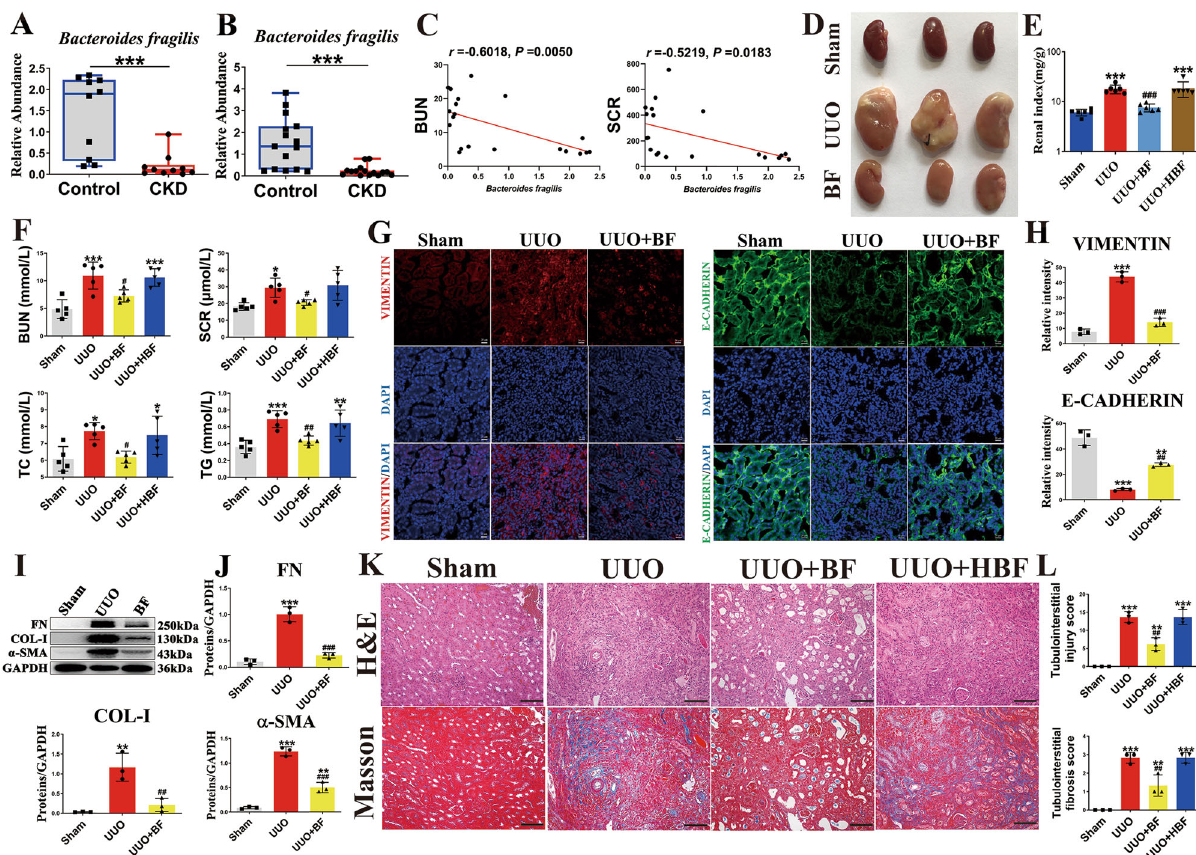
Fig. 1 | The anti- fi brotic effects of B fragilis in UUO model. A The relative abun- danceof B. fragilis inthe CKDand controlgroupsfrom Renmin Hospitalof Wuhan UniversitymeasuredbyqPCR( n =10).*** p =0.0005. B Therelativeabundanceof B. fragilis in the CKD and control groups from the Putuo People ’ s Hospital measured byqPCR( n =15).*** p <0.0001.Boxplotsshowcenterlineasmedian,whiskersshow maxima and minima, and box limits show upper and lower quartiles. C Pearson ’